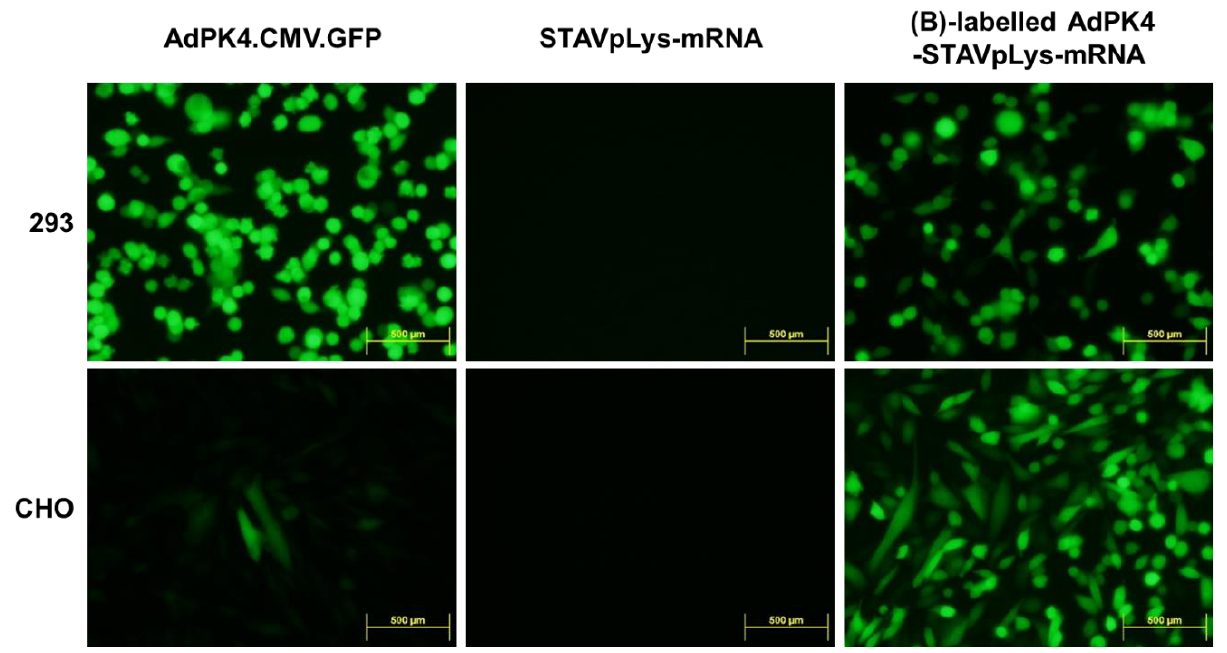
Figure 3. Polylysine enhancement of adenovirus gene transfer. Adenovirus permissive (HEK293) and non-permissive (CHO) cell lines were infected with either AdPK4.CMV.GFP alone, polylysine conjugated mRNA alone (STAVpLys-mRNA) or the AdpL-mRNA conjugate. The AdpL conjugate demonstrated enhanced gene transfer of GFP encoded by the viral DNA to CHO cells, potentially via interaction of polylysine with the cell surface. The fluorescence images were analyzed forty-eight hours after virus infection using fluorescence microscopy.